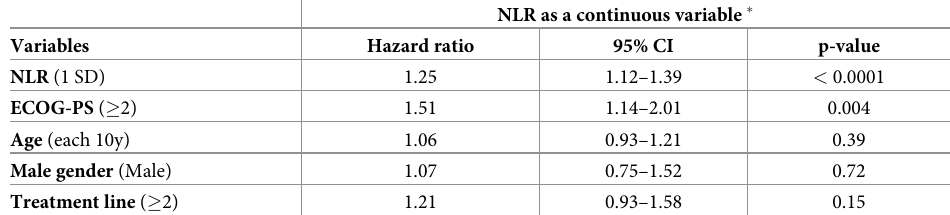
Table 2. Multivariate analysis in the overall cohort of patients receiving chemotherapy (cohort 1 + cohort 2, n = 451) with neutrophil-to-lymphocyte ratio as a continuous